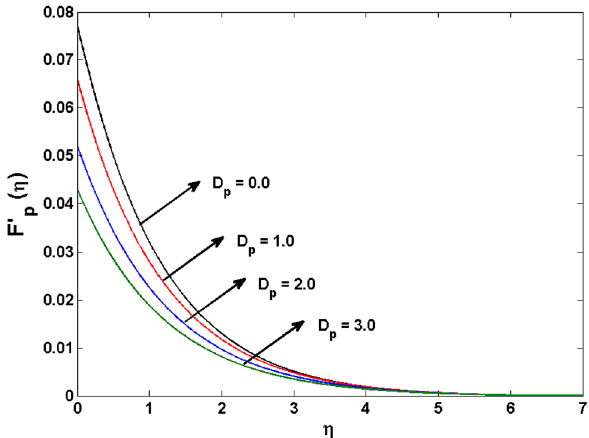
Figure 6. F ′ p (ζ) for various estimates of D p .